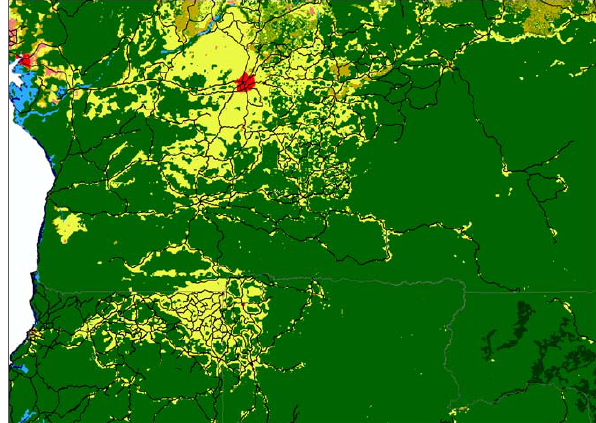
Table 7. Forest areas for 10% or 30% tree crown cover.